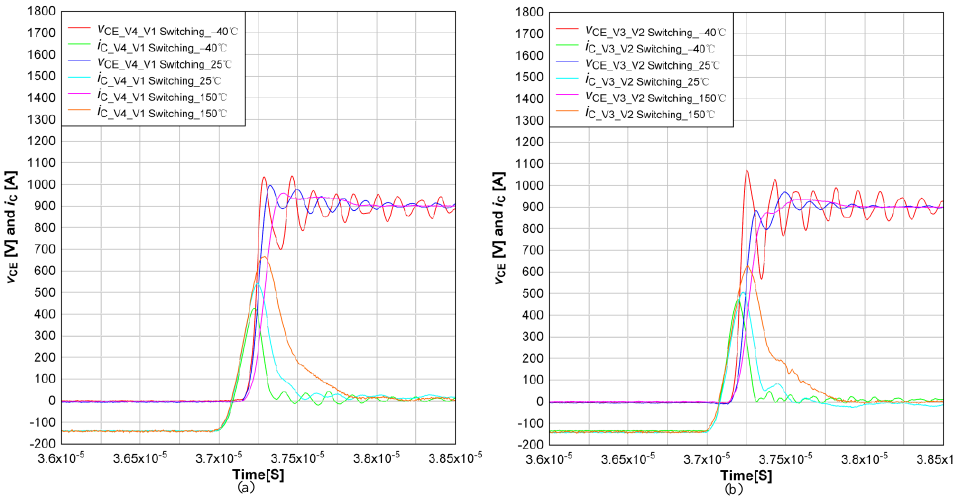
Figure 29. FF1400R17IP4 reverse recovery with 0.9 kV off voltage and 140 A (T vj = −40 °C, 25 °C, and 150 °C, V GEon = +15 V, R Gon = 0.9 Ω). ( a ) The outer commutation path. ( b ) The inner commutation path.